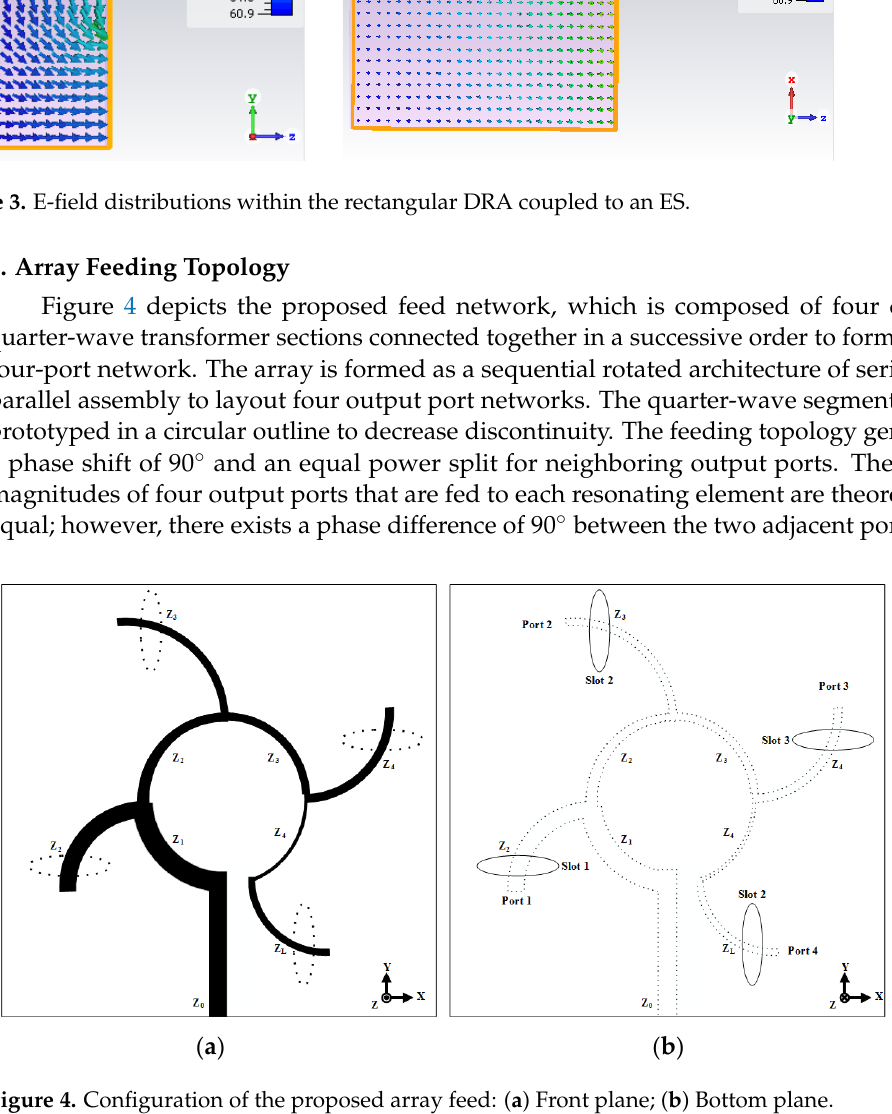
Figure 3. E-field distributions within the rectangular DRA coupled to an ES.